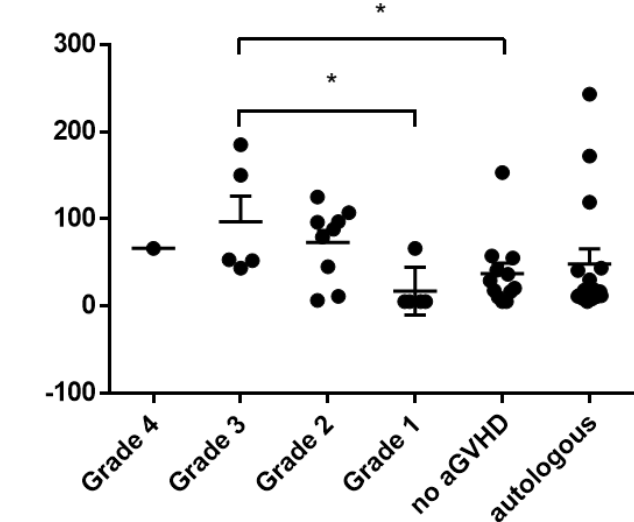
Figure 4. Correlation of mumps titers and severity of acute GvHD (grades 1–4) compared to patients without GvHD and autologous patients. Asterisks mark significant p -values.